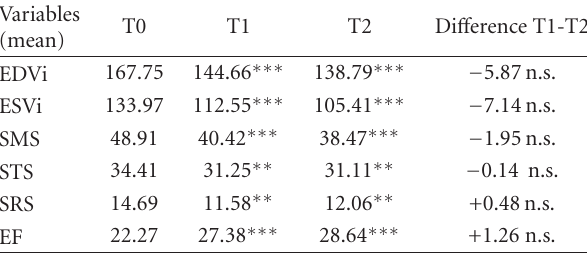
Table 2: Value of scintigraphic variable obtained at baseline and at short- and medium-term of followup. T0: time 0, T1: first step of followup, T2: second step of followup. EDVi: end diastolic